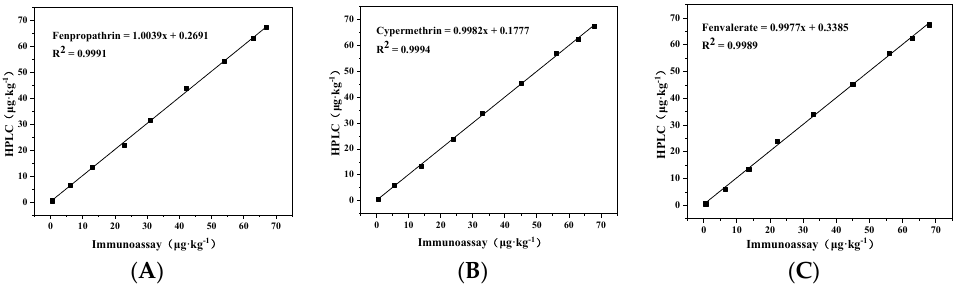
Figure 6. Correlation between HPLC and this research method in the detection of ( A ) fenpropathrin; ( B ) cypermethrin and ( C ) fenvalerate.